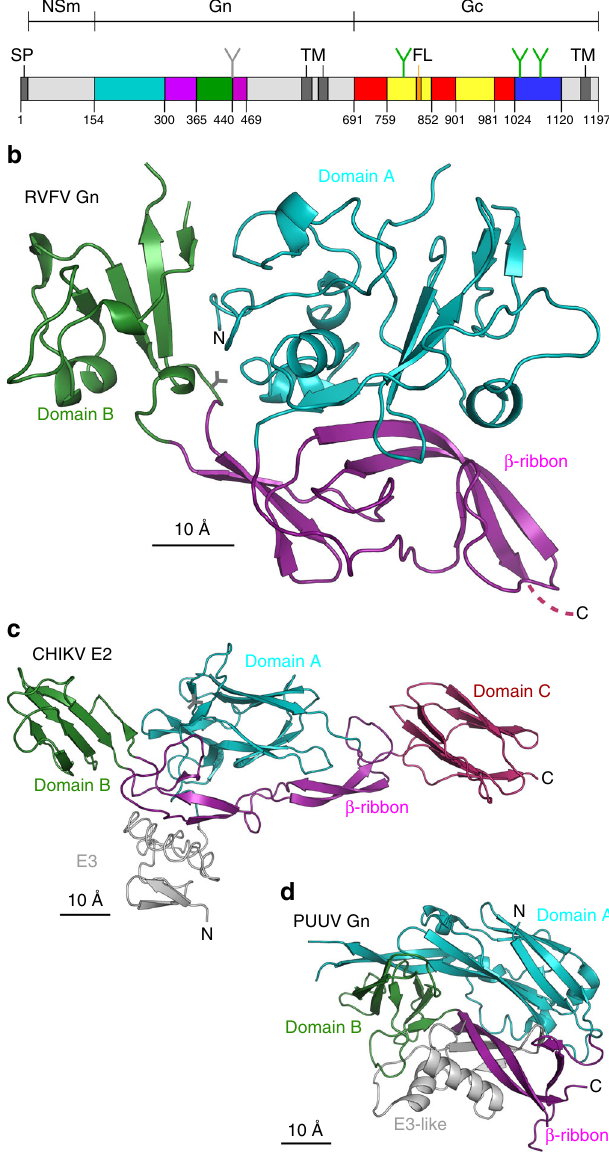
Fig. 1 Novel fold of Rift Valley fever virus Gn glycoprotein. a The domain organisation of the M-segment of RVFV showing the domain organisation of Gn and Gc by colour. Domain A is teal, domain B is forest green, the β -ribbon is purple, domain I is red, domain II is yellow, domain III is blue and the hydrophobic fusion loop (FL) is orange. Transmembrane regions are indicated with TM, signal peptide is indicated with SP and glycan positions are indicated with a Y. b The crystal structure of Gn from Rift Valley fever virus. Domains are coloured as in a and the position of a predicted glycan is indicated with a Y. c Structures of E2 and E3 from Chikungunya virus (CHIKV) 17 . d Structure of Gn from Puumala virus (PUUV) 15 . RVFV Gn adopts a novel fold but shares a similar domain organisation with CHIKV E2. Both proteins have a β -ribbon with two anti-parallel β -sheets and a domain B inserted into the β -ribbon. In CHIKV, E2 domain B is a β sandwich, while in RVFV Gn domain B is a small β sheet decorated with four short helices. Domain A of CHIKV E2 and PUUV Gn are both a seven stranded β sandwich with the same topology (Supplementary Figure 1)